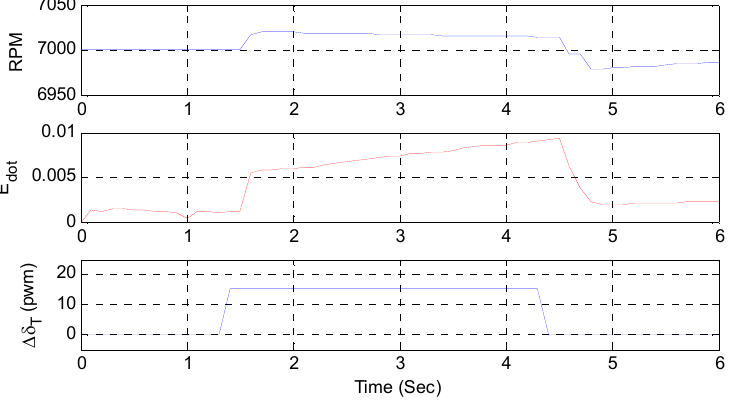
. E s with an increment of throttle Figure 7. The response of the ∆ Figure 7. The response of the ∆(cid:1831) (cid:2929) (cid:4662) with an increment of throttle input. Table 2. The average value of ∆(cid:1831) (cid:2929) (cid:4662) from positive throttle input. PWM, Pulse Width Modulation. ∆(cid:2748) (cid:1794) ((cid:1790)(cid:1797)(cid:1787)) = (cid:2778)(cid:2782)